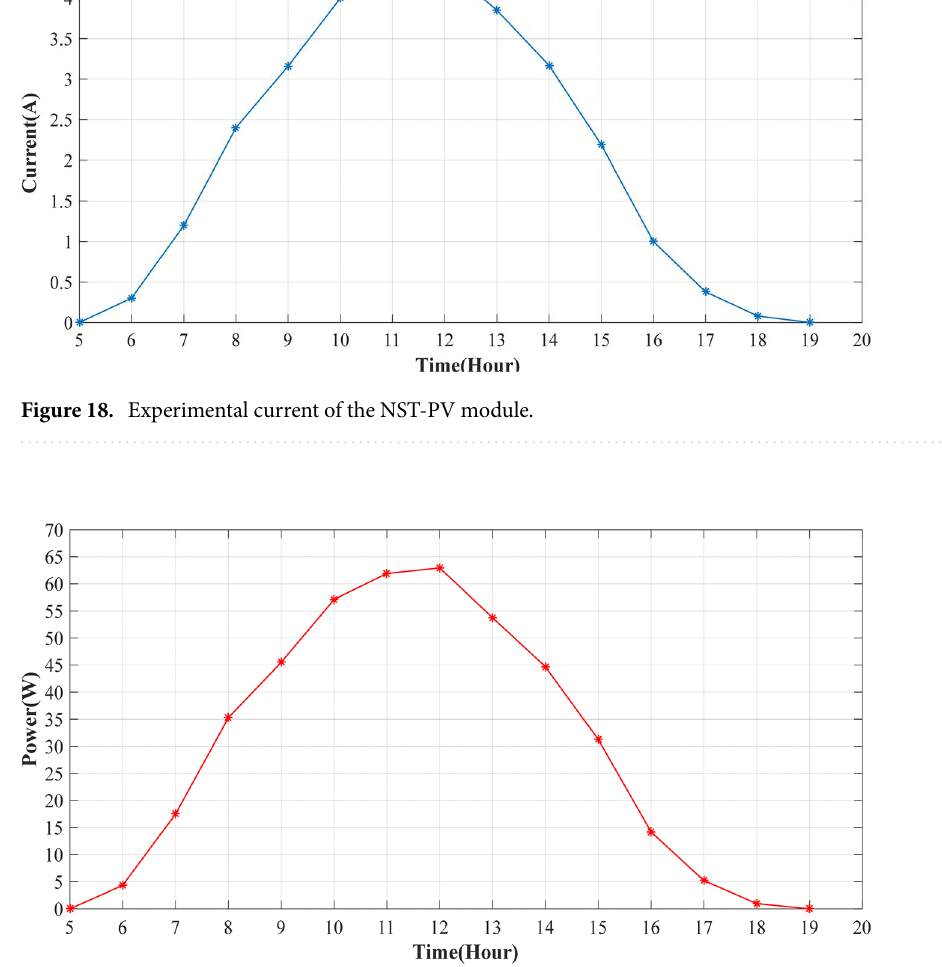
Figure 19. Experimental power of the NST PV module.